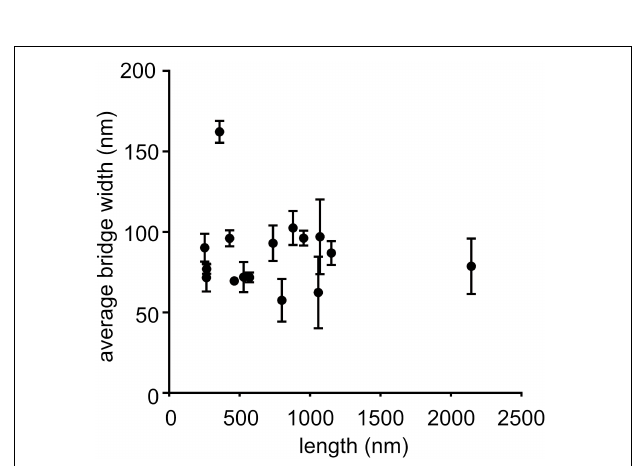
FIGURE 3 | Determination of length and width of cell–cell bridges. Scatter plot of length against the corresponding average width of cell–cell bridges. Six measurements of width per bridge were taken and average width with corresponding error were determined. Only cell–cell bridges were considered that connected two cells together ( n =